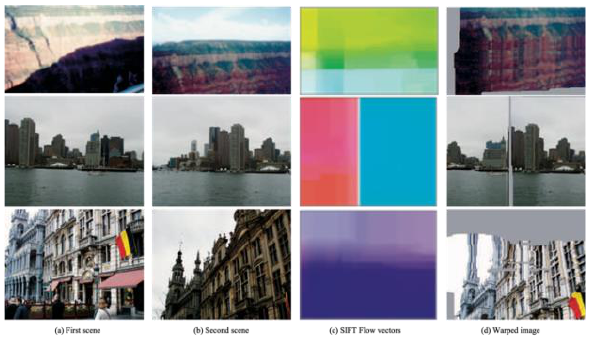
Figure 2. Scene alignment application of SIFT